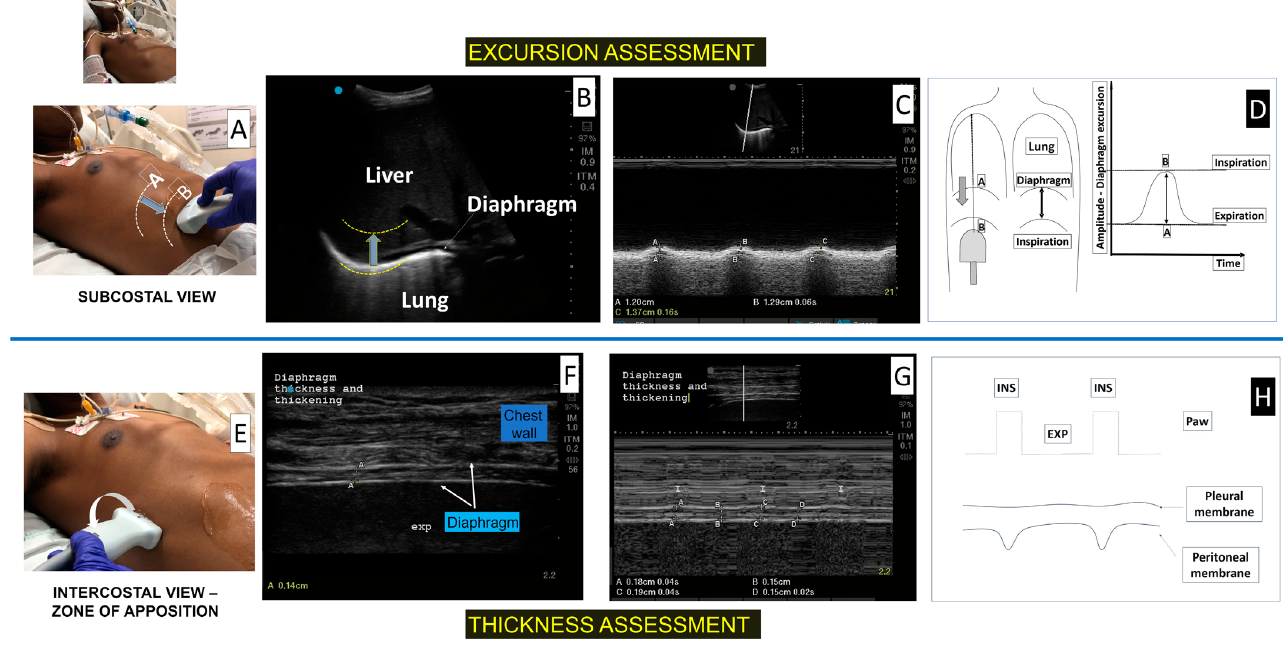
Figure 2. Diaphragm ultrasound to assess excursion and thickness – technique description in a critical care patient on mechanical ventilation. (Panel A ): Probe positioning on subcostal area. (Panel B ): Bidimensional view displaying the diaphragm as a white hyperechoic curved line (yellow traced) separating lung from liver. (Panel C ): M-Mode view displaying a normal excursion during tidal breathing after a brief disconnection of the ventilatory support. (Panel D ): Graphic illustrative of the excursion measurement. (Panel E ): Probe positioning on the intercostal area (zone of apposition, ZA)—after positioning the linear probe perpendicularly to the costal wall, we rotated the probe (counterclockwise) to obtain the corresponding ultrasound image on the right. (Panel F ): Bidimen- sional view displaying the diaphragm as a hypoechoic structure surrounded by 2 hyperechoic lines (pleural and peritoneal membranes). (Panel G ): M-Mode view displaying a normal inspiratory thickening of diaphragm during tidal breathing in a critical care patient on mechanical ventilation (I = inspiration; points A and C represent end-inspiratory diaphragm thickness; points B and D represent end-expiratory diaphragm thickness. (Panel H ): Graphic illustrative of the thickness and thickening